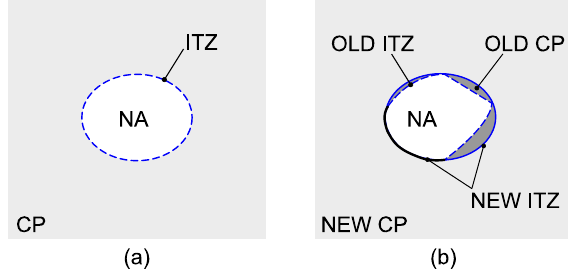
Figure 2. Idealized interaction and interfacial transition zones (ITZ) between natural aggregate (NA) with cement paste (CP) (a) and recycled aggregate with new cement paste (CP) (b).